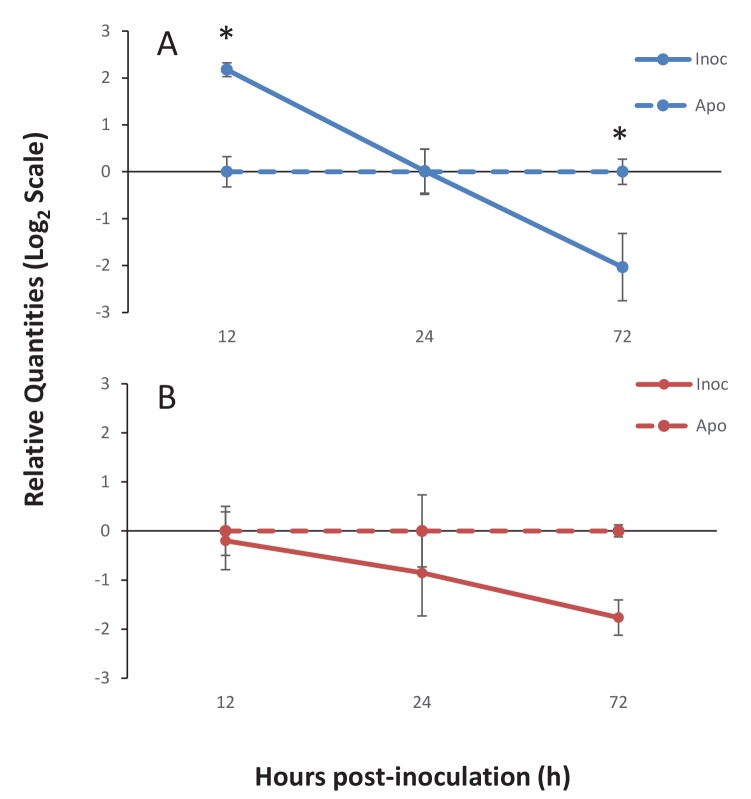
Gene expression of Ap_Sema5 and Ap_Trypsin-like at the onset of symbiosis.The relative quantities from qPCR on the log2 scale are shown for animals that were inoculated with symbionts (‘Inoc’; solid line) and those that remained aposymbiotic (‘Apo’; dashed line). Bars represent means ± SE (n = 3) and stars represent significantly different levels of expression between the inoc and apo treatments at a particular time point (two-way ANOVA, Tukey’s post hoc test). *p<0.05, **p<0.01.DOI:
http://dx.doi.org/10.7554/eLife.24494.01810.7554/eLife.24494.019Figure 6—source data 1.Source data used for statistical analyses described in results and depicted in Figure 6.Long-form table with experimental results described in the results section Ap_Sema-5 expression increases at early time-points during the onset of symbiosis and shown in Figure 6.